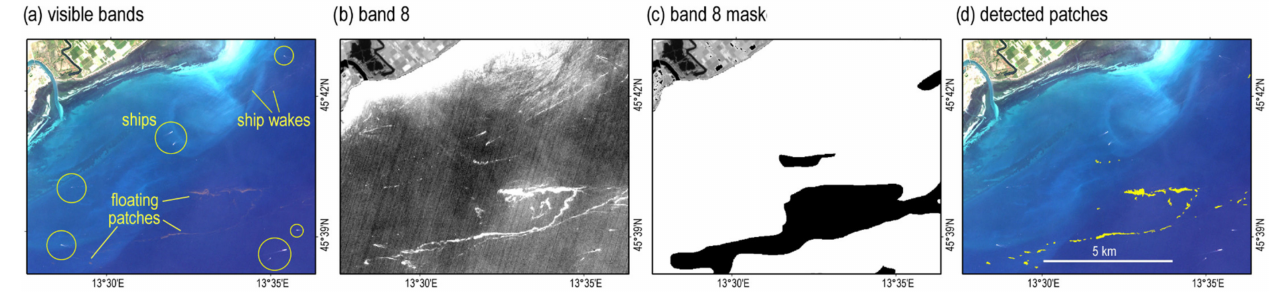
Figure 2. ( a ) Patches of floating materials, boats, and wakes in the visible channels. ( b ) NIR (band 8 of Sentinel-2). ( c ) Mask applied around the patches. ( d ) Detected patches using the threshold of 0.02 in band 8 (Sentinel-2 tile: 33TUL, 21 August